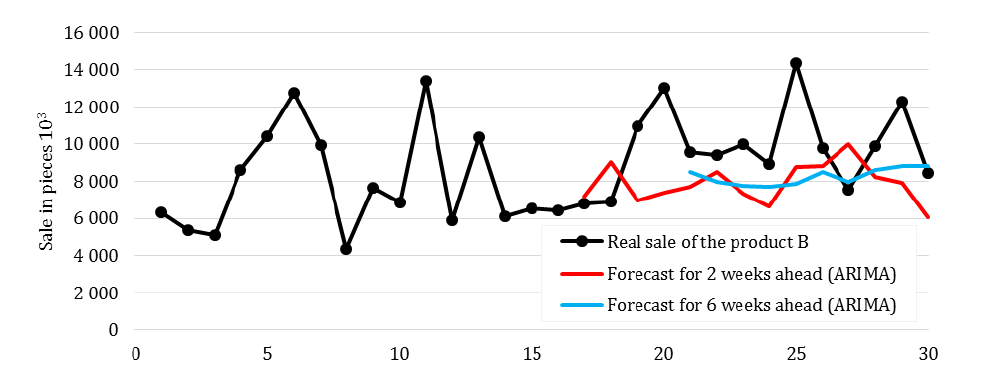
Figure 3: Real sale of the product B and forecasts by ARIMA.